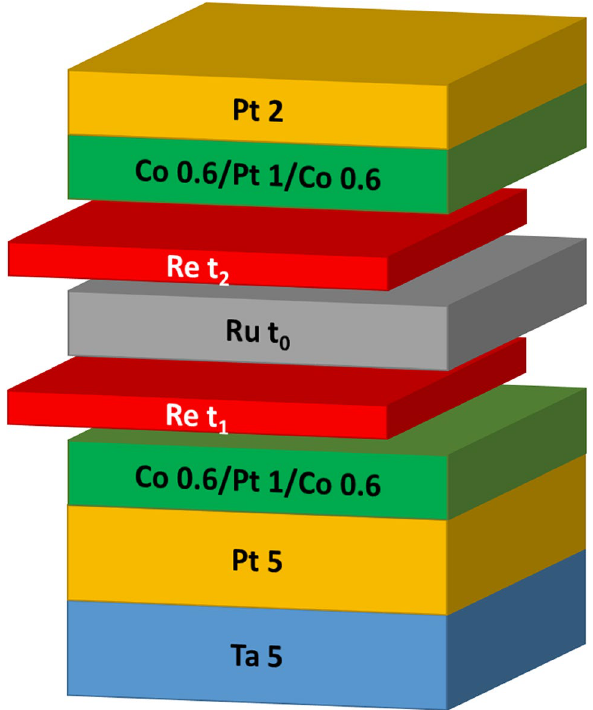
Figure 1. Schematic diagram for film stack of the SAF layer. Re is inserted at top and/or bottom of Ru. The numbers represent layer thickness in